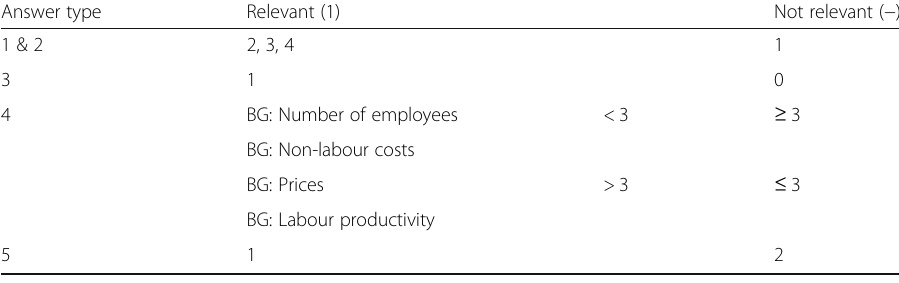
Table 9 Scheme of answer harmonisation for adjustment channel